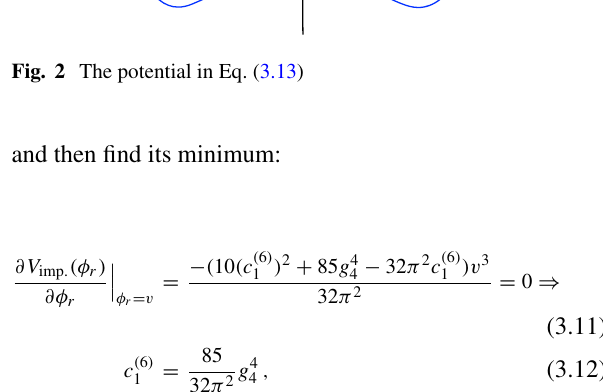
Fig. 2 The potential in Eq.